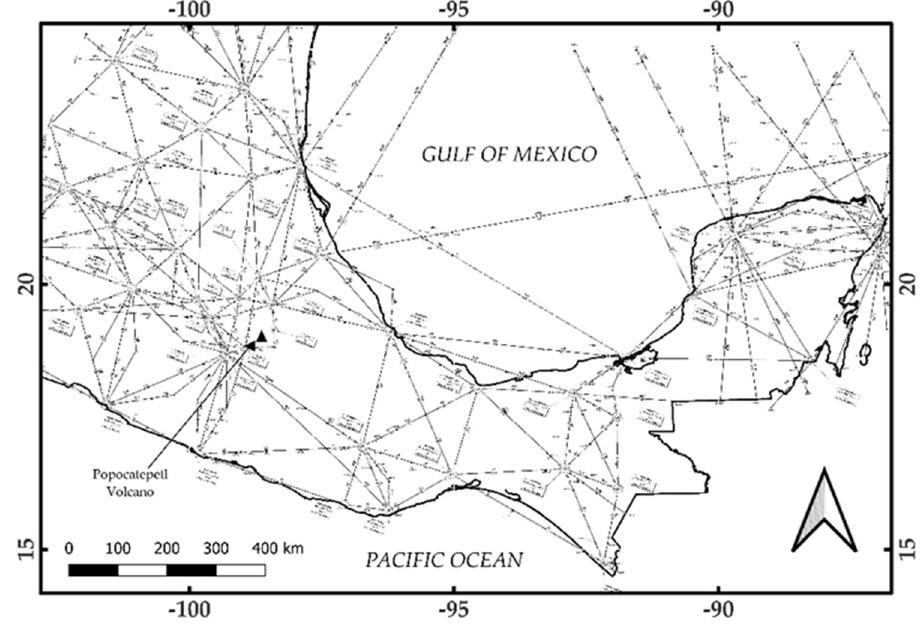
Figure 1. Airway map of Central Mexico. The Popocatepetl volcano is located in the central part of the country. (Modified from aeronautical chart of the upper airspace L2, published by SENEAM (Servicio a la Navegación en el Espacio Aéreo Mexicano, in Spanish)).